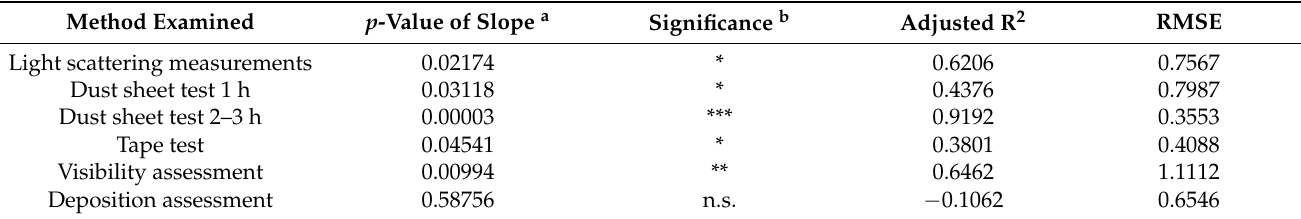
Table 1. Results on the significance of the slopes of the regression lines for the log-transformed dust concentration of the reference method as a function of the dust concentrations of the methods under examination. The adjusted coefficient of determination (adjusted R 2 ) and the Root-Mean-Square Error (RMSE) of each model are also